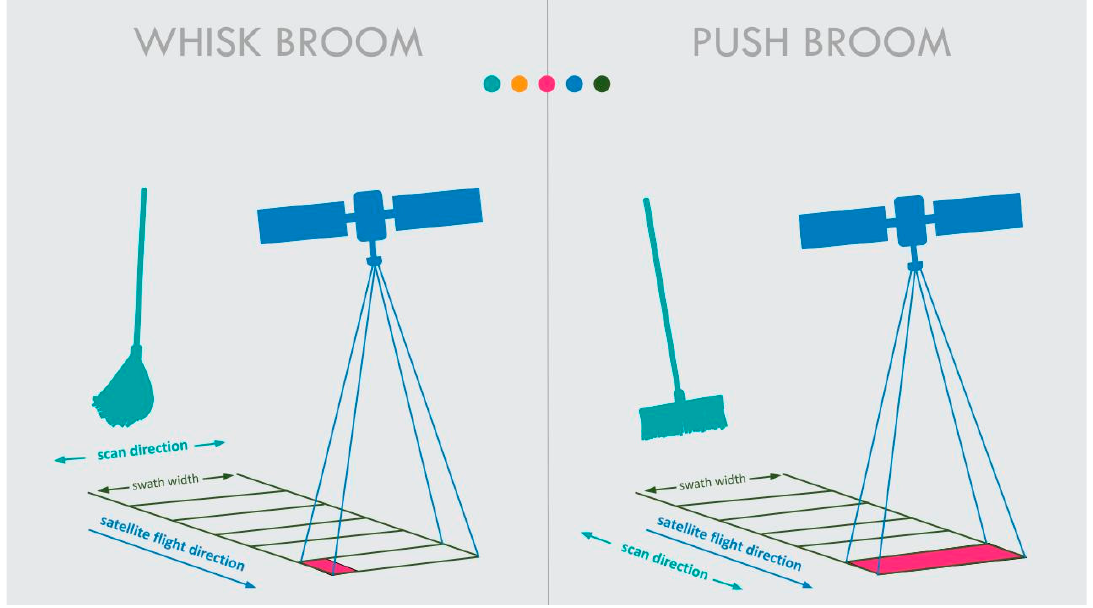
Figure 4. Demonstration of differences between two commonly used optical sensors: whisk broom and push broom. Adapted with permission from Florian Hillen’s illustrations [51].